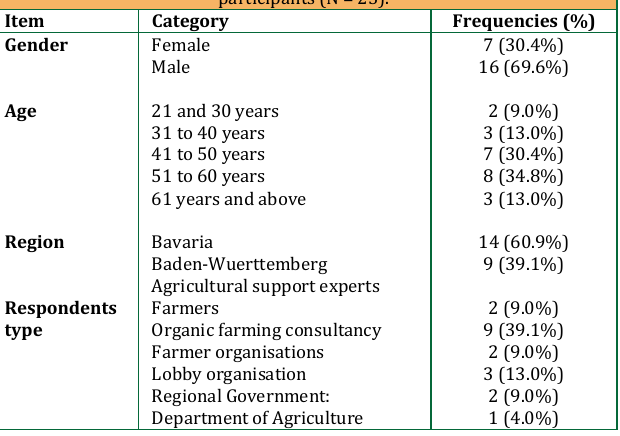
Table 1: Cross-sectional study demographic information of the participants (N = 23).